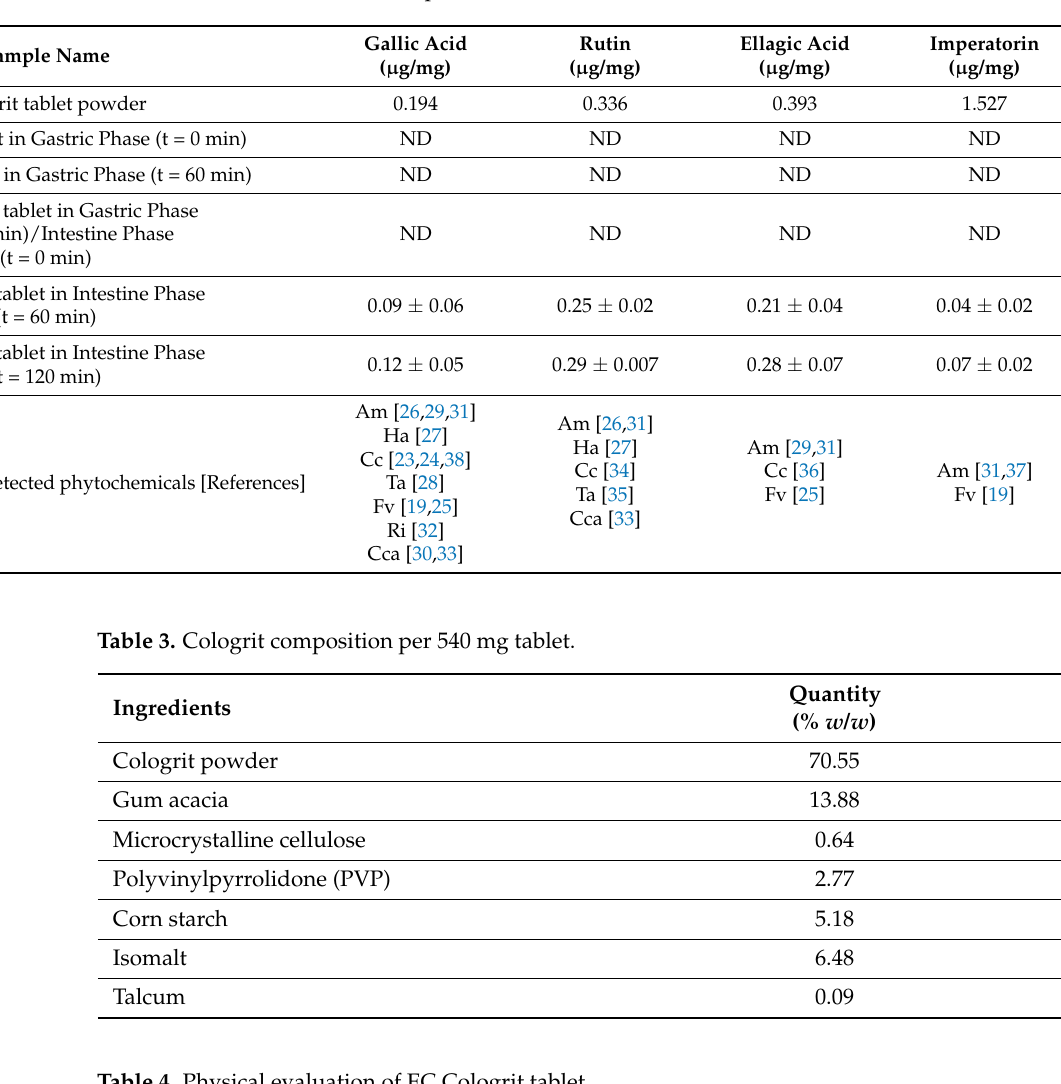
Table 2. HPLC analysis of EC Cologrit tablet dissolutions. Results represent Mean ± SD (N = 3). According to literature review, individual phytochemicals have been identified in Aegle marmelos (L.) Corr ê a (Am); Holarrhena antidysenterica (L.) Wall. ex A. DC (Ha); Cuminum cyminum L. (Cc); Trachysper- mum ammi (L.) Sprague (Ta); Foeniculum vulgare Mill. (Fv); Rosa indica L. (Ri); Cinnamomum camphora